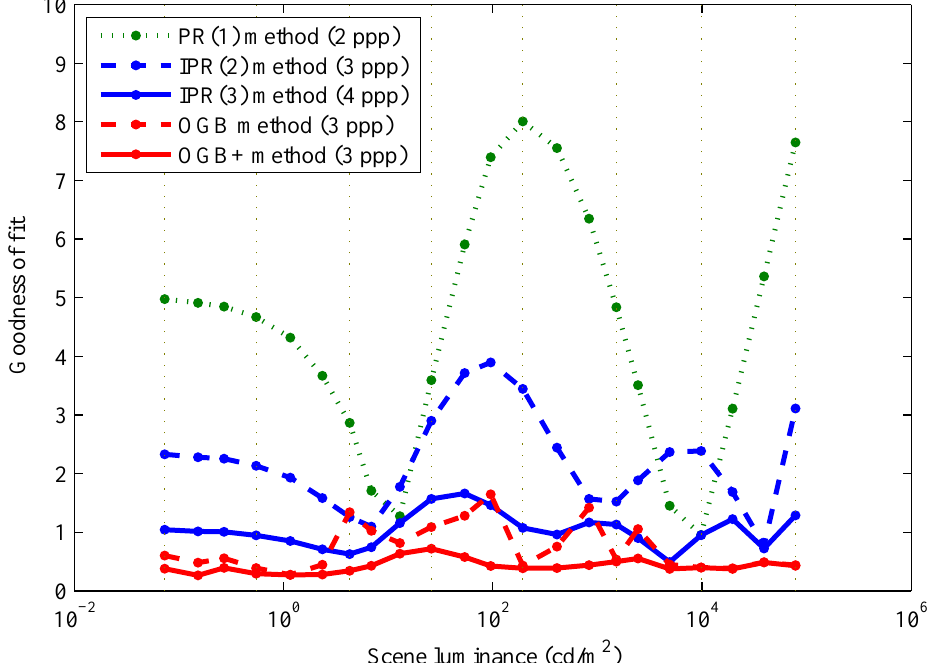
Figure 5. Comparing goodness of fit per luminance. This ratio divides RMS residual FPN per luminance by overall RMS temporal noise. Unlike the OGB method, the OGB+ method, also taken from the literature, corrects for luminance errors. However, unlike both OGB methods, the IPR method requires only arithmetic operations for FPN